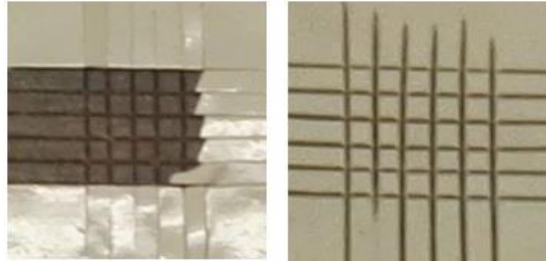
Figure A4. Exemplary results of the cross-cut test according to DIN EN ISO 2409 of PP60 before (left) and after (right) plasma treatment with synthetic air. The reference is assigned to class 0, the plasma-treated one, due to the still completely intact grid, to class 5.